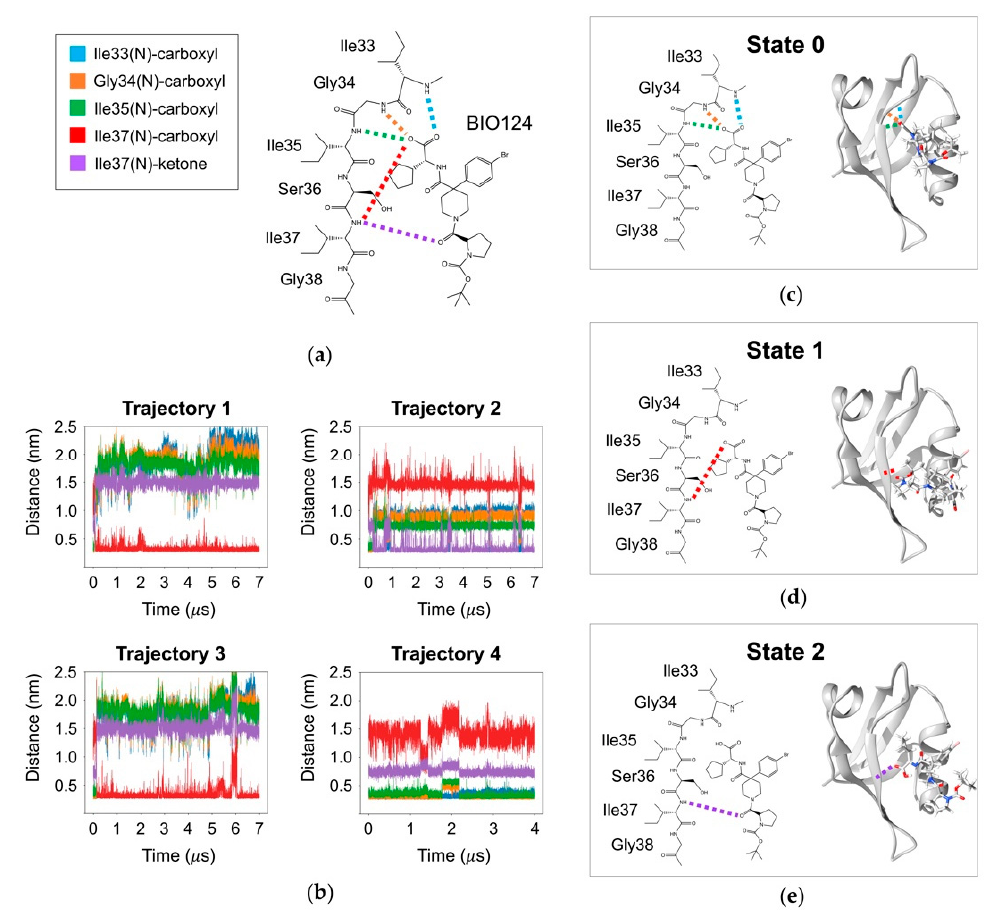
Figure 3. The three binding conformations of BIO124. ( a ) Hydrogen bonding pairs between BIO124 and the PICK1 PDZ domain. ( b ) Atom-atom distance analysis of the hydrogen bonding pairs in the PICK1 PDZ-BIO124 complex by trajectory. Distance analysis suggests unique binding conformations of BIO124. ( c ) State 0 of BIO124 (trajectory 4). Hydrogen bonding network (left) and cluster analysis (right) are in good agreement. State 0 resembles the conformation of the ligand in the crystalized structure. ( d ) State 1 of BIO124 (trajectories 1 and 3). Hydrogen bonding network (left) and cluster analysis (right) are in good agreement. State 1 is new stable conformations taken by the ligand during our simulations. ( e ) State 2 of BIO124 (trajectory 2). Hydrogen bonding network (left) and cluster analysis (right) are in good agreement. State 2 is new stable conformations taken by the ligand during our simulations.